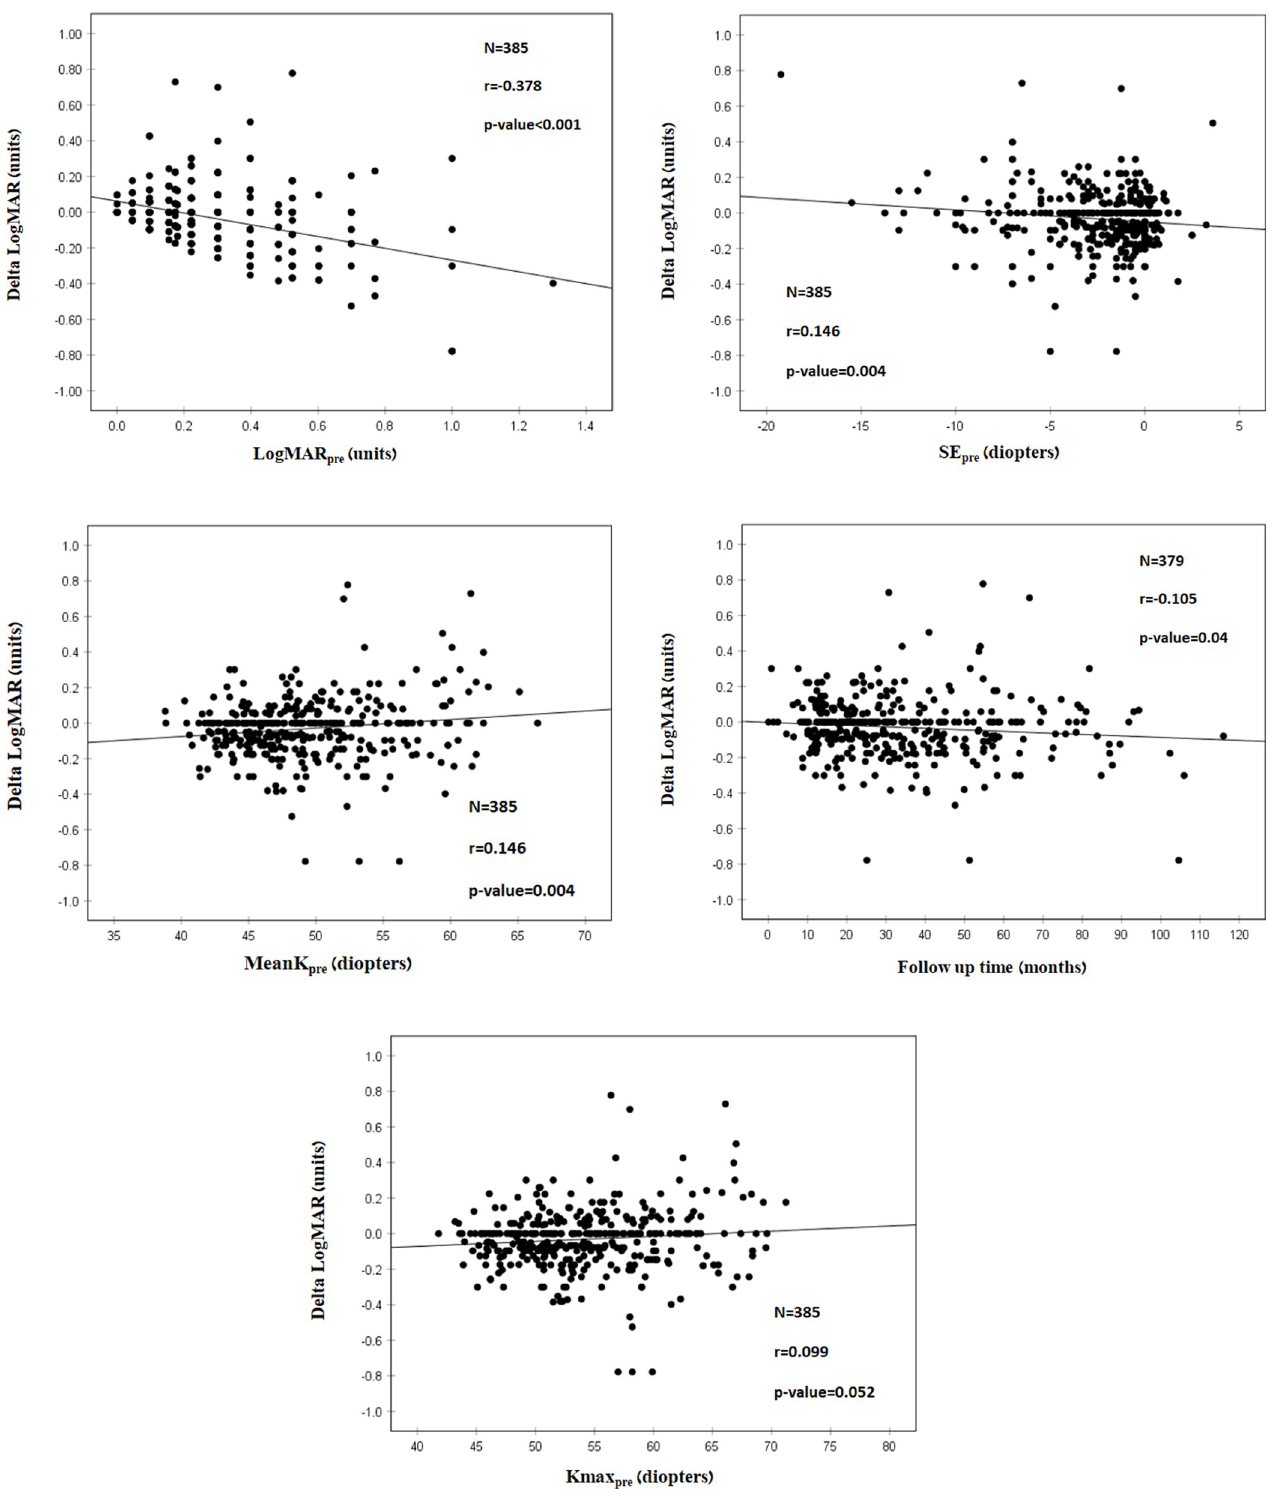
Fig 4. A. Correlation between LogMAR pre1 and Delta LogMAR 2 . More negative Delta LogMAR was correlated with higher LogMAR pre . r 3 = -0.378. These results indicate that poorer baseline visual acuity can predict better treatment outcomes with a greater improvement of visual acuity. 1 LogMAR pre = Logarithm of minimal angle of resolution before crosslinking. 2 Delta LogMAR = (Logarithm of minimal angle of resolution after crosslinking)–(Logarithm of minimal angle of resolution before crosslinking). 3 r = Pearson correlation coefficient. B. Correlation between MeanK pre1 and Delta LogMAR 2 . More negative Delta